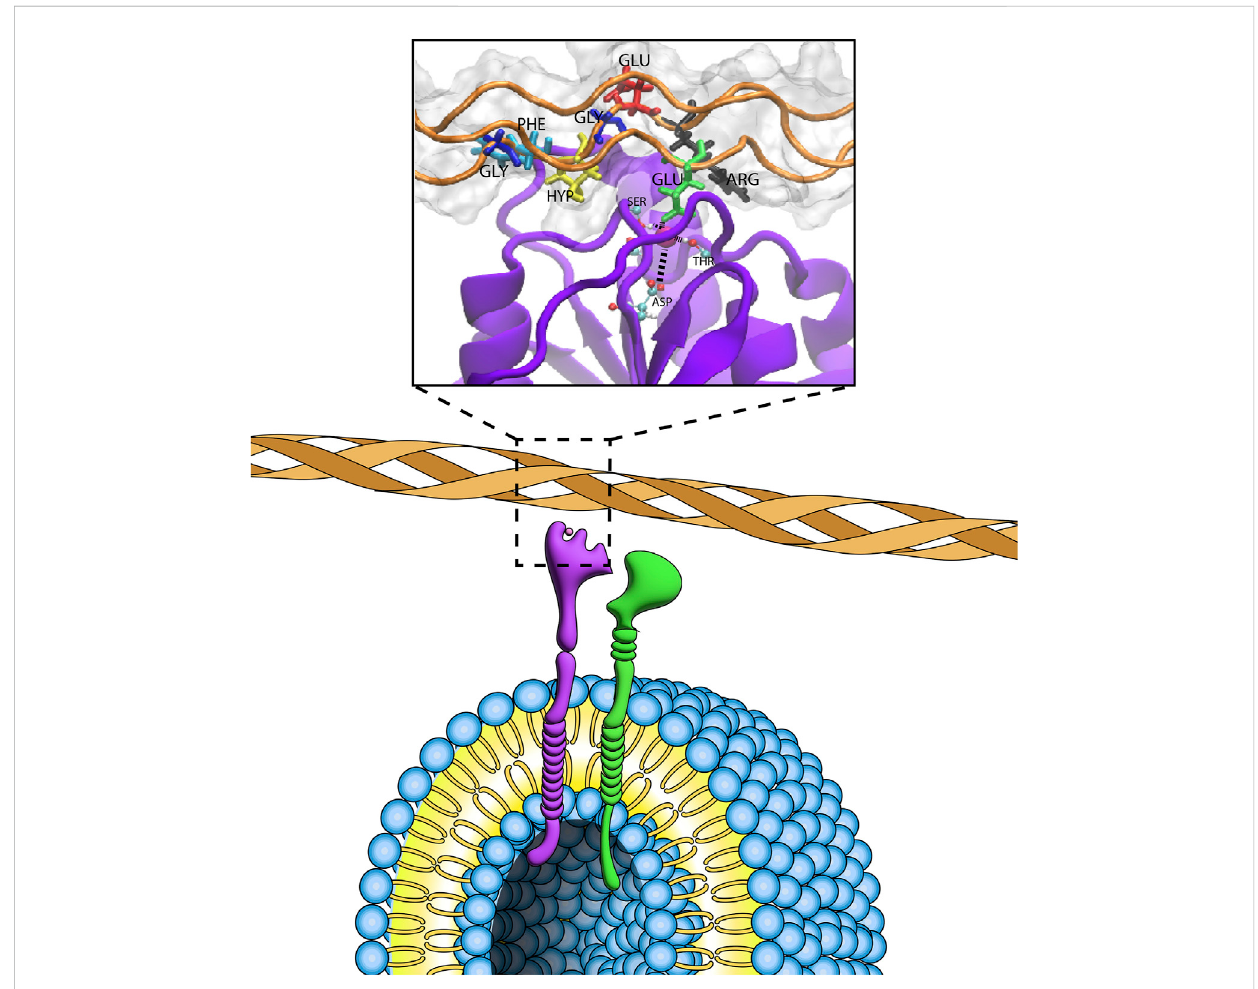
FIGURE 1 Sytem of study. Artistic representation of the α 2 β 1 binding collagen. The inset corresponds to the PDB structure 1dzi, focusing on the speci fi c motif area “ GFOGER ” on the collagen fi ber